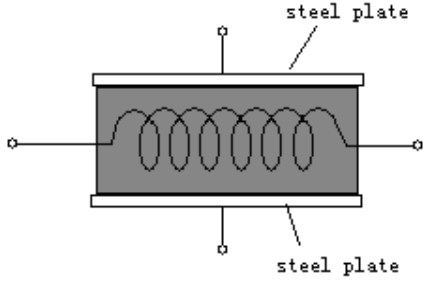
Figure 6. The structure of the special sensor.